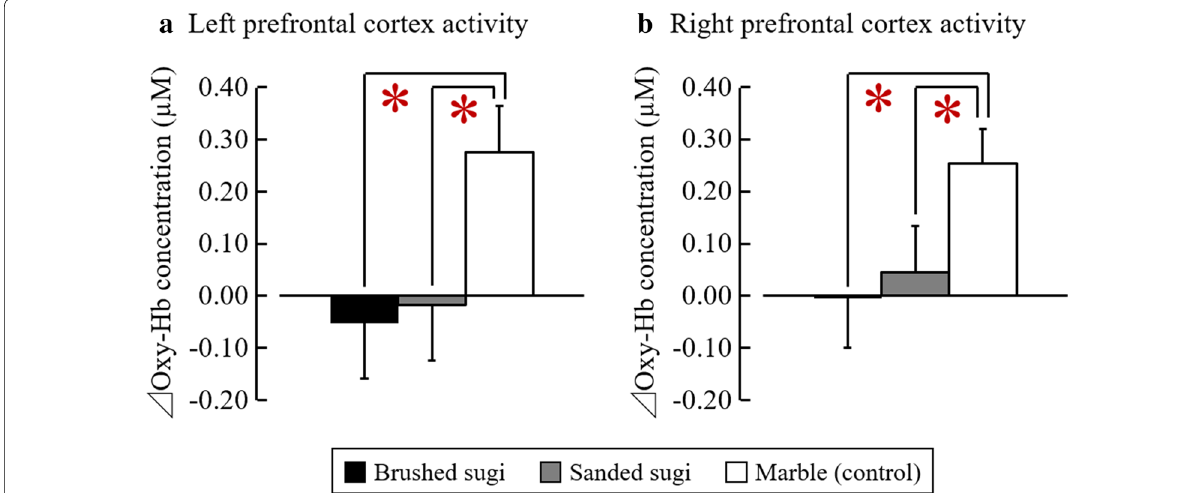
Fig. 2 Response of brain activity indices during contact of materials via the palm of the right hand. a Overall mean oxy-hemoglobin (oxy-Hb) concentration in the left prefrontal cortex. b Overall mean oxy-Hb concentration in the right prefrontal cortex. N